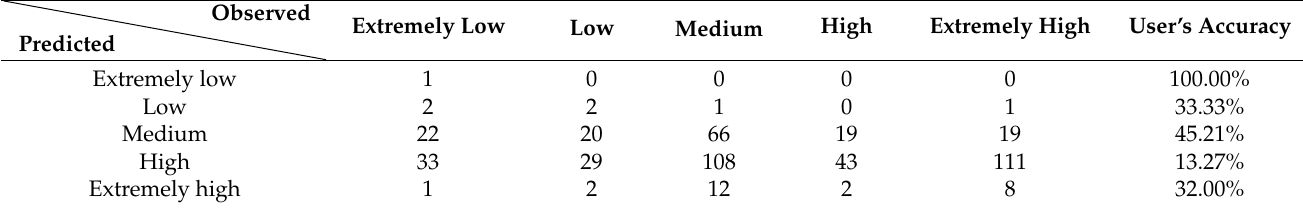
Table 9. Allocation confusion matrix of